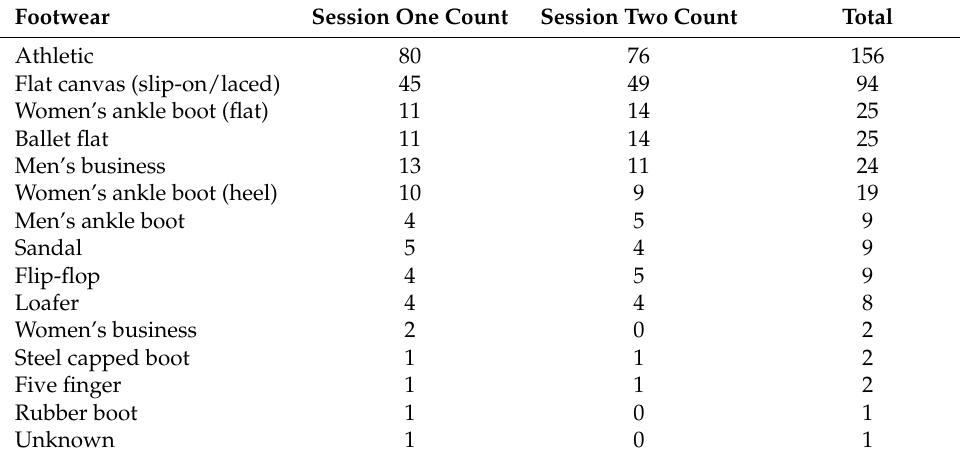
Table 2. Distribution of footwear in the